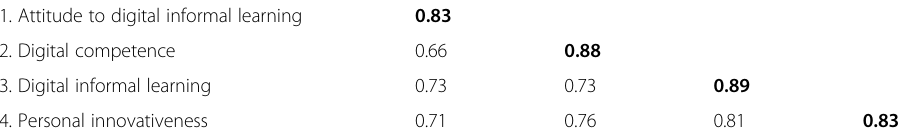
Table 5 Discriminant validity 1. Attitude to digital informal learning